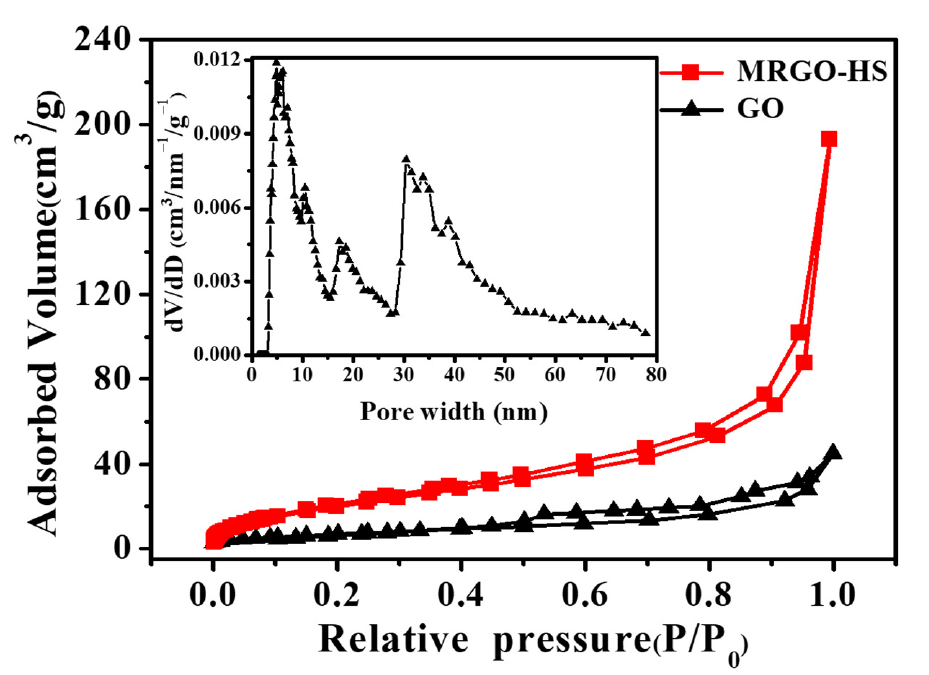
Figure 9. N 2 adsorption/desorption isotherms of GO and MRGO-HS. The inset image is the pore size distribution curves of MRGO-HS.